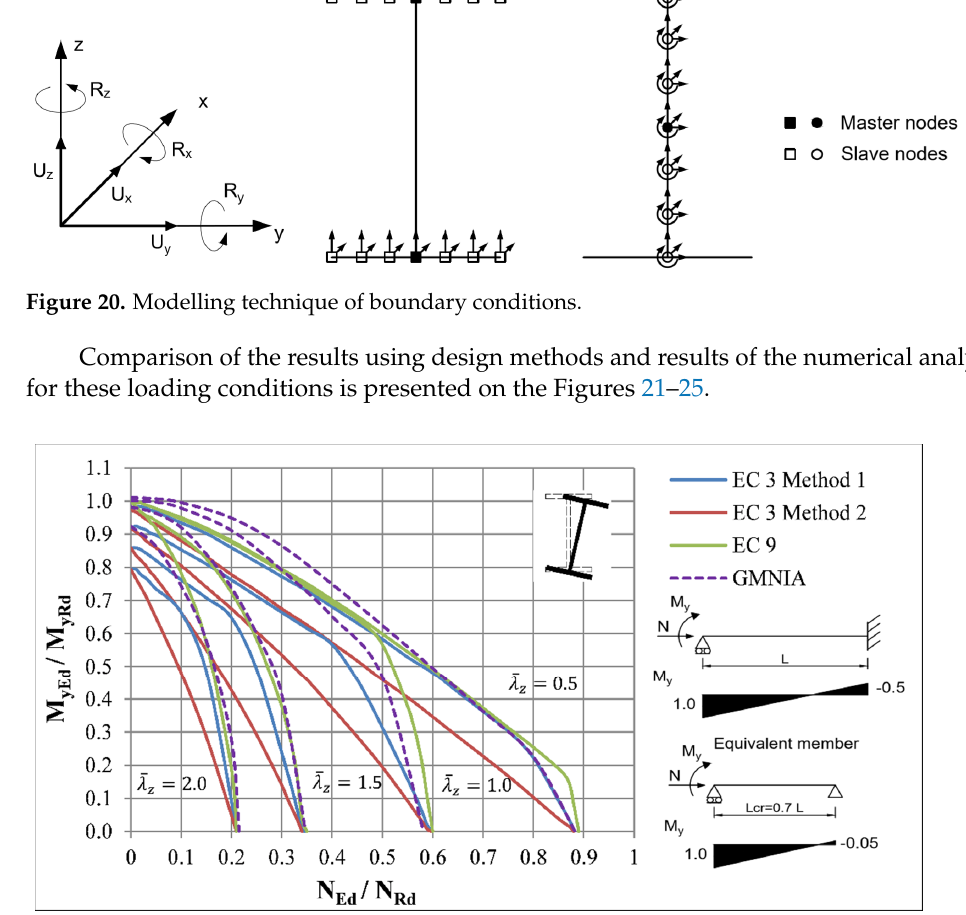
Figure 19. The deformation of the beam-column without warping restraints at failure (scale factor = 12).